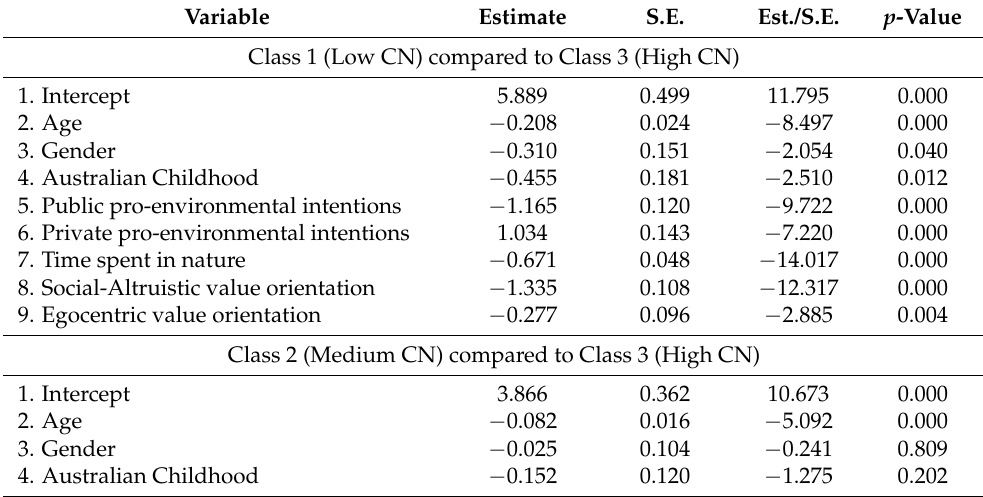
Table 6. Comparison of membership between classes with Social-Altruistic Value Orientation